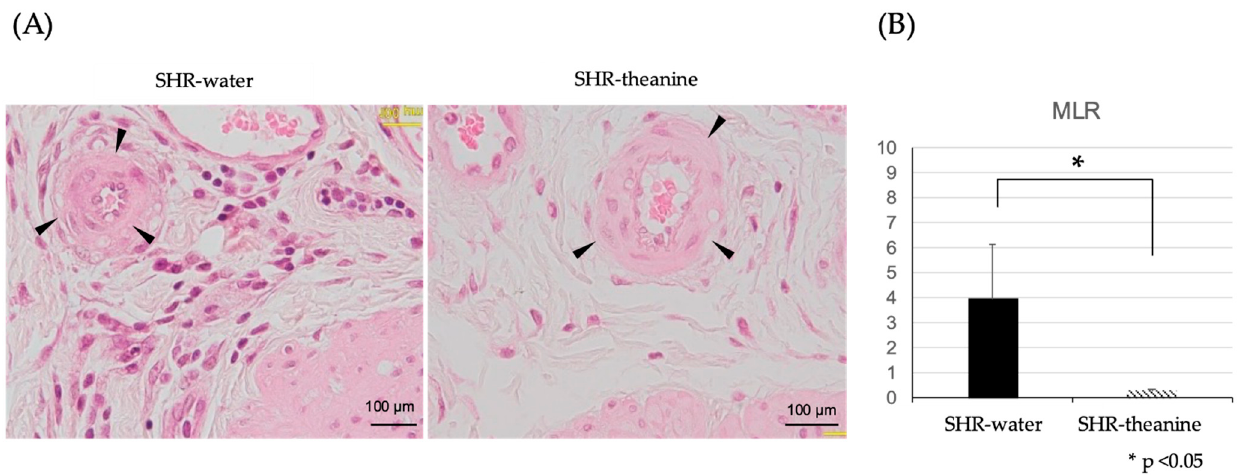
Figure 6. Media-to-lumen ratio of bladder small arteries the SHR-water and SHR-theanine groups: ( A ) hematoxylin and eosin staining of suburothelial arterioles (arrowheads) in SHR treated with water and treated with L -theanine, scale bars = 100 µM; ( B ) the MLR is significantly lower in the SHR–theanine group than in the SHR–water group ( B ). * Statistical significance at the p < 0.05 level.